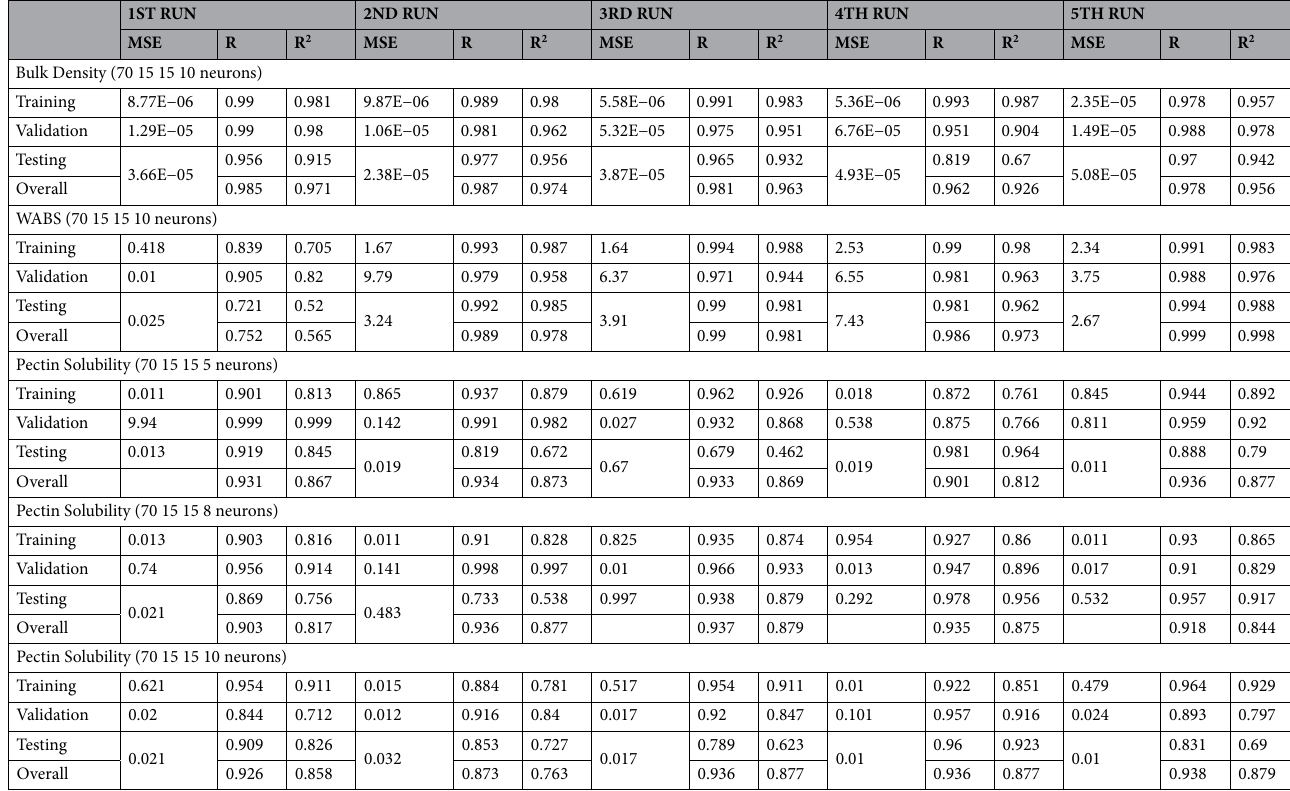
Table 3. MSE, R and R 2 Values obtained from Model Training, Validation and